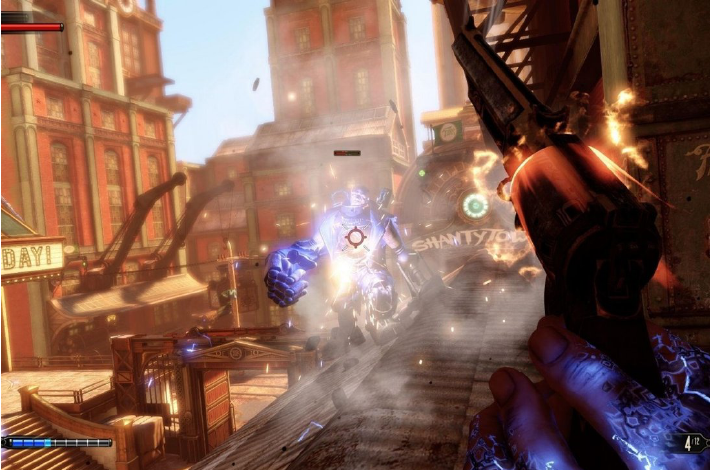
Figure 5. BioShock Infinite game. Image taken from: Video game Bioshock Infinite, posted by Pavan Shamdasani, 2013.